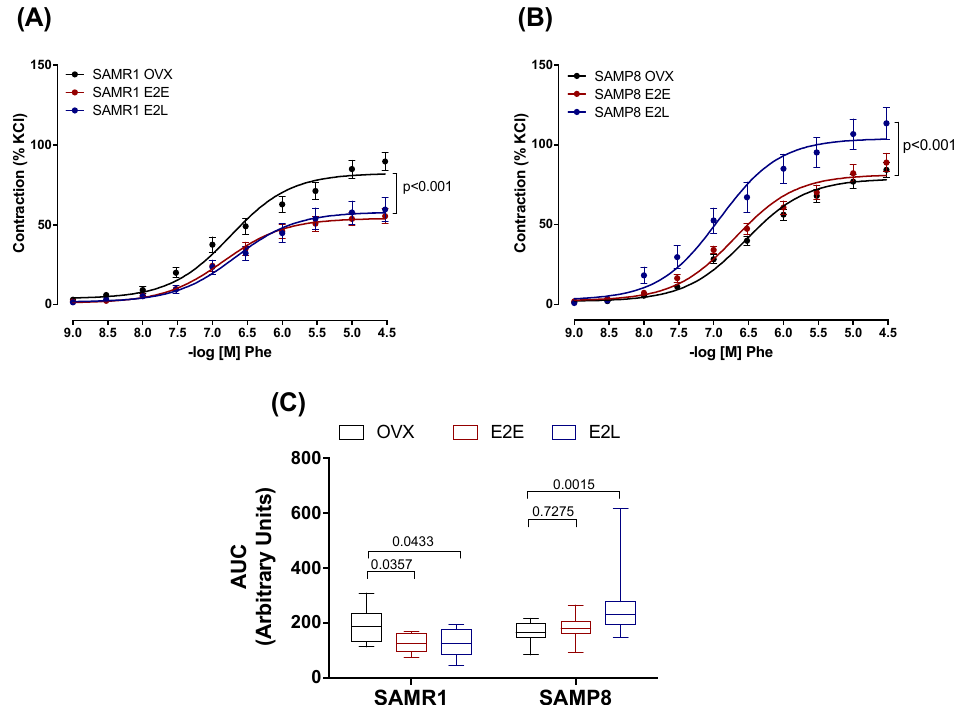
Figure 1. Phenylephrine-induced contractions. Concentration–e ff ect curves to Phenylephrine (Phe) determined in endothelium-intact common carotids arteries from SAMR1 ( A ) and SAMP8 ( B ) female mice. Curves were obtained in vessels from untreated ovariectomized mice (OVX), and ovariectomized mice receiving early-onset (E 2 E) or late-onset (E 2 L) of 17 β -estradiol treatment. Di ff erences in vascular responses are expressed as the area under the curve (AUC) ( C ). Each point of the curve and bar graphs represents the mean ± SEM from 10–18 independent experiments. The extra sum-of-squares F. One-way ANOVA determined di ff erences in the fit of concentration–response curves analyzed the dependence of data on the onset of estrogen therapy (none, early, or late) in SAMR1 or SAMP8 with Bonferroni’s post-test. p -values and comparisons are expressed next to the curves and on top of bar graphs. Significance is considered when p < 0.05.